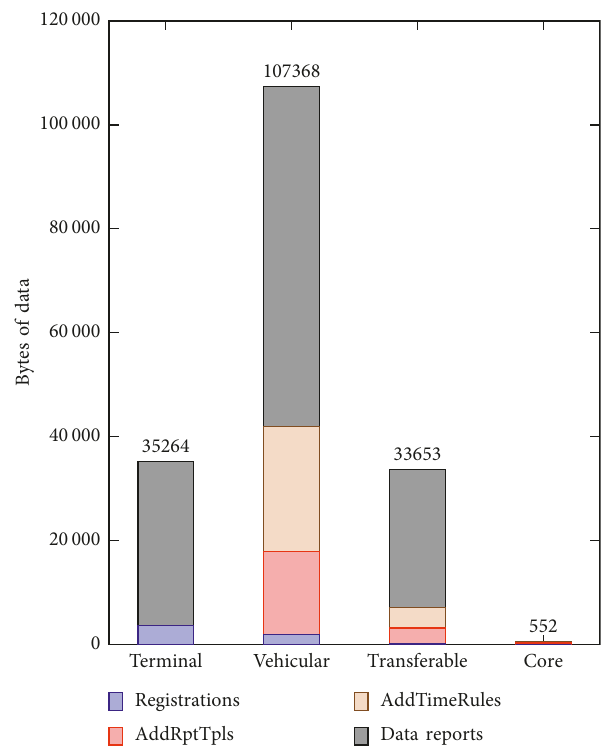
Figure 11: DTN management data sent by nodes in different